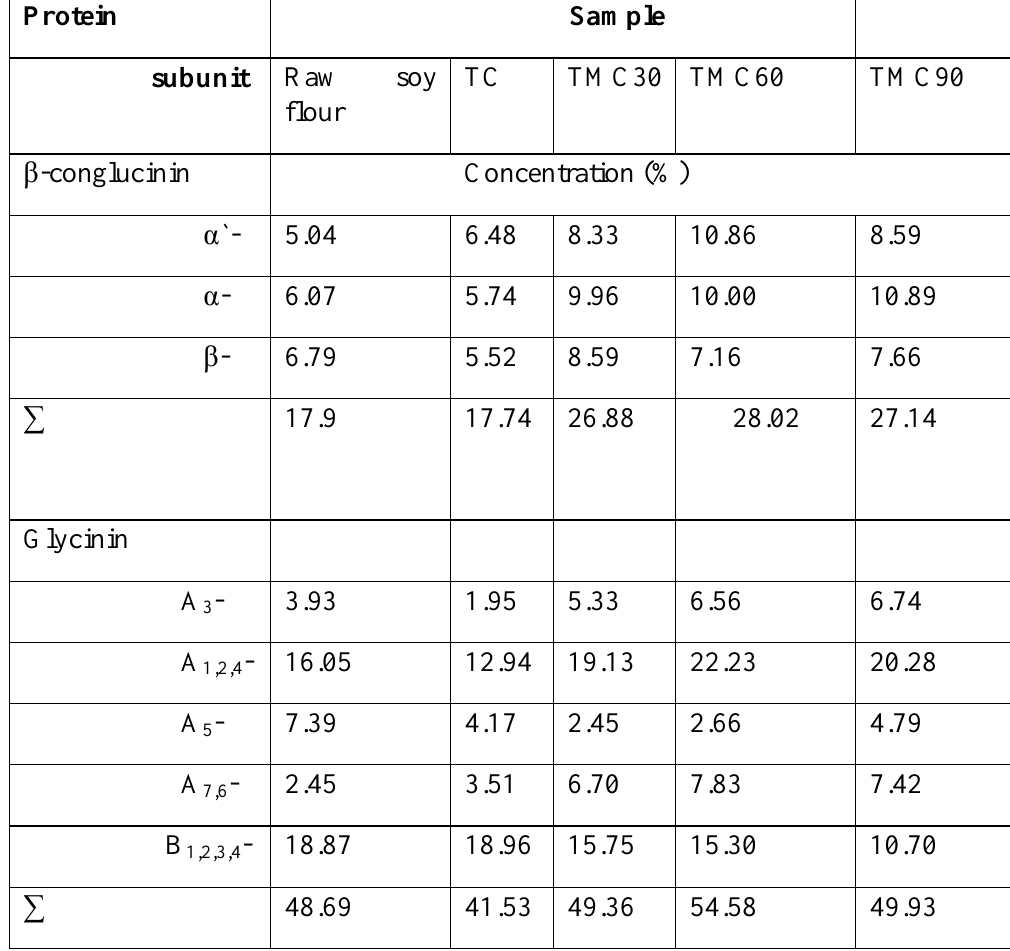
Table 2. The subunits composition of Tris-HCl extracts of soy flour, traditional and trypsin- modified